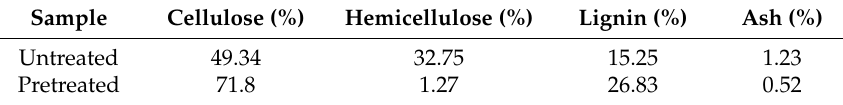
Table 5. Composition of MxG before and after dilute sulfuric acid pretreatment.